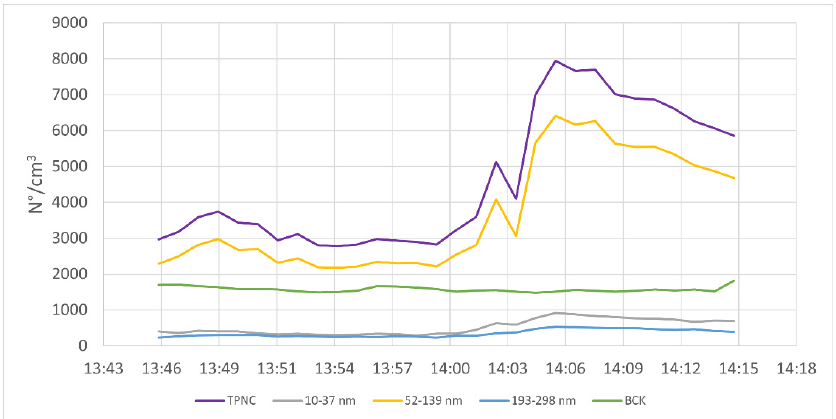
Figure 6. TPNC trends and the main particle size classes for O5–sifting of recovered powder.